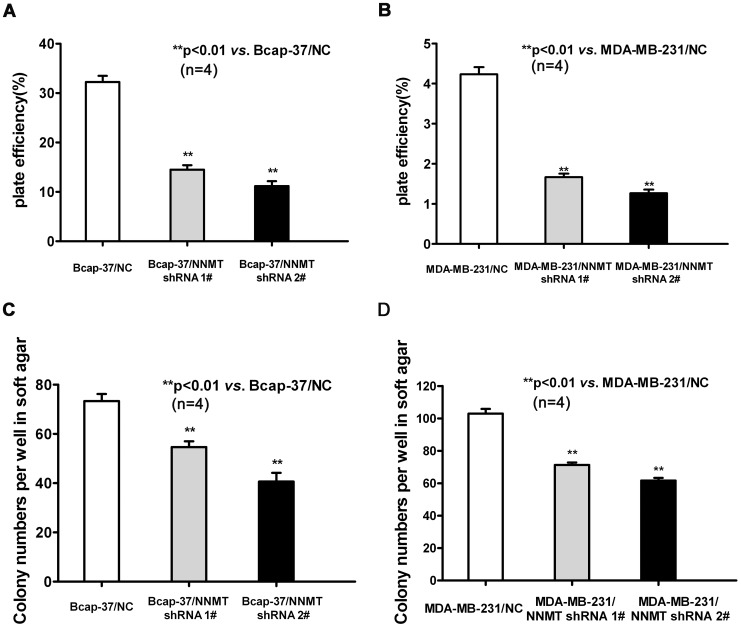
Down-regulation of NNMT expression decreased the plate efficiency and attenuated the capacity of colony formation in soft ager(A, B) To test plate colony formation of Bcap-37 and MDA-MB-231 cells infected with NNMT shRNAs, cells were placed in wells with media and incubated for 14 days before counting the number of colonies (foci>50 µm). The plate efficiency of Bcap-37/NNMT shRNA 1# and Bcap-37/NNMT shRNA 2# cells were lower than that of Bcap-37/NC group. The similar result was found in MDA-MB-231 cell models (B). (C, D) Colony formation of Bcap-37 and MDA-MB-231 infected with NNMT shRNAs was carried out by placing cells in media containing soft ager for 14 days. The numbers of Bcap-37/NNMT shRNA 1# and Bcap-37/NNMT shRNA foci >100 µm were less than that of Bcap-37/NC group (**P<0.01). The similar result was found in MDA-MB-231 cell models (D). Values are expressed as means ± SD of four independent experiments.